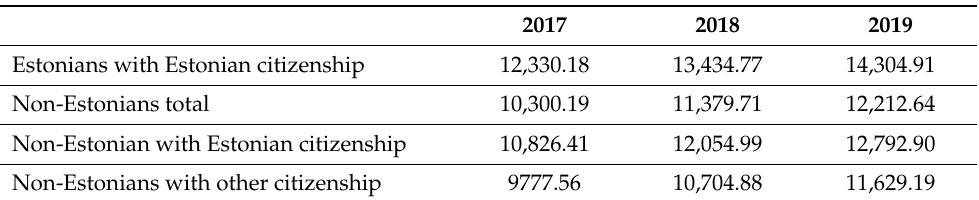
Table 1. Equalized yearly disposable income by ethnic nationality and citizenship in euros (Estonian Statistics